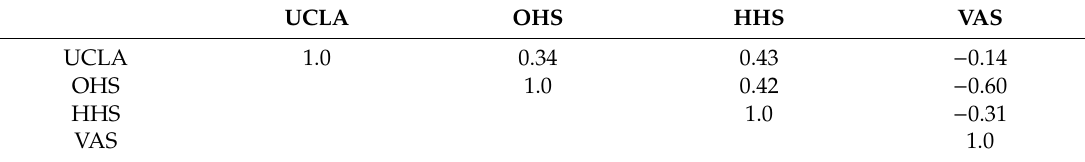
Table 5. Spearman rank correlation coe ffi cient for each combination of clinical